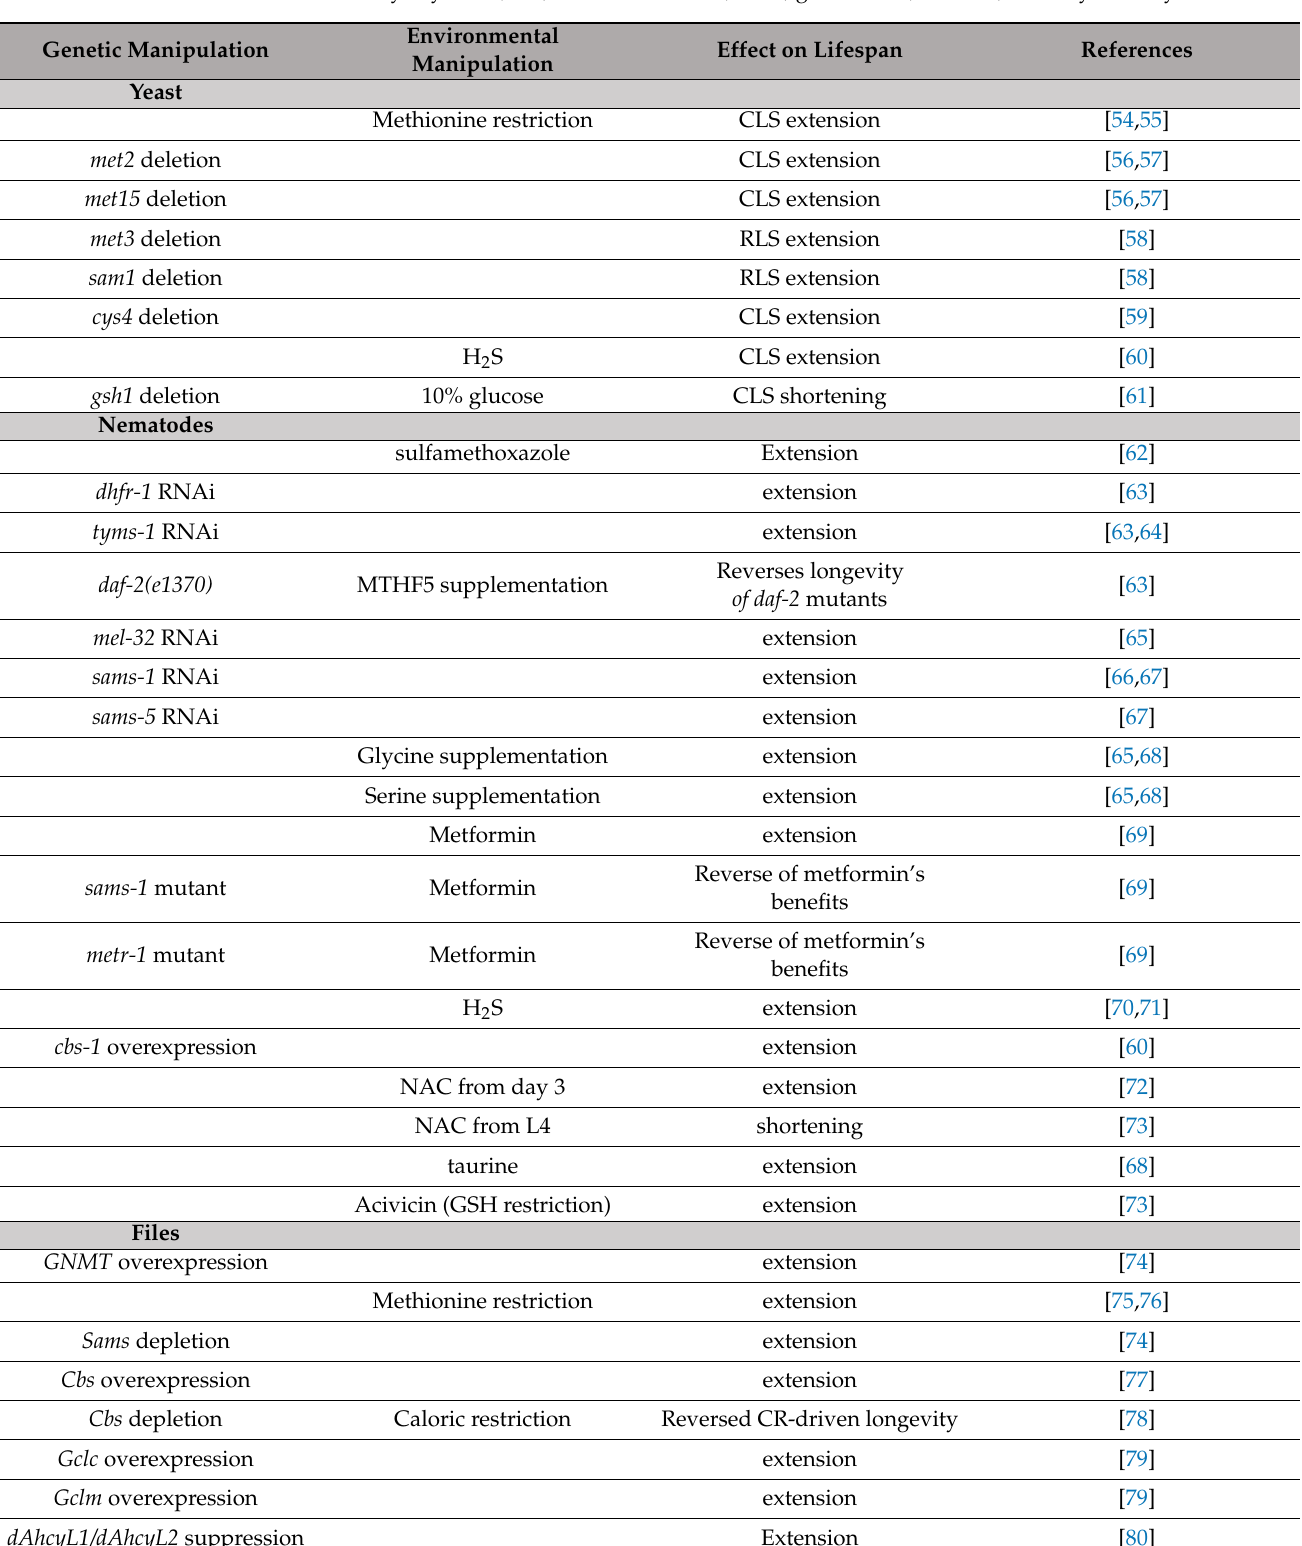
Table 1. Genetic and environmental manipulations that impact lifespan via modulation of one-carbon metabolism and associated pathways. CLS, chronological lifespan; RLS, replicative lifespan;